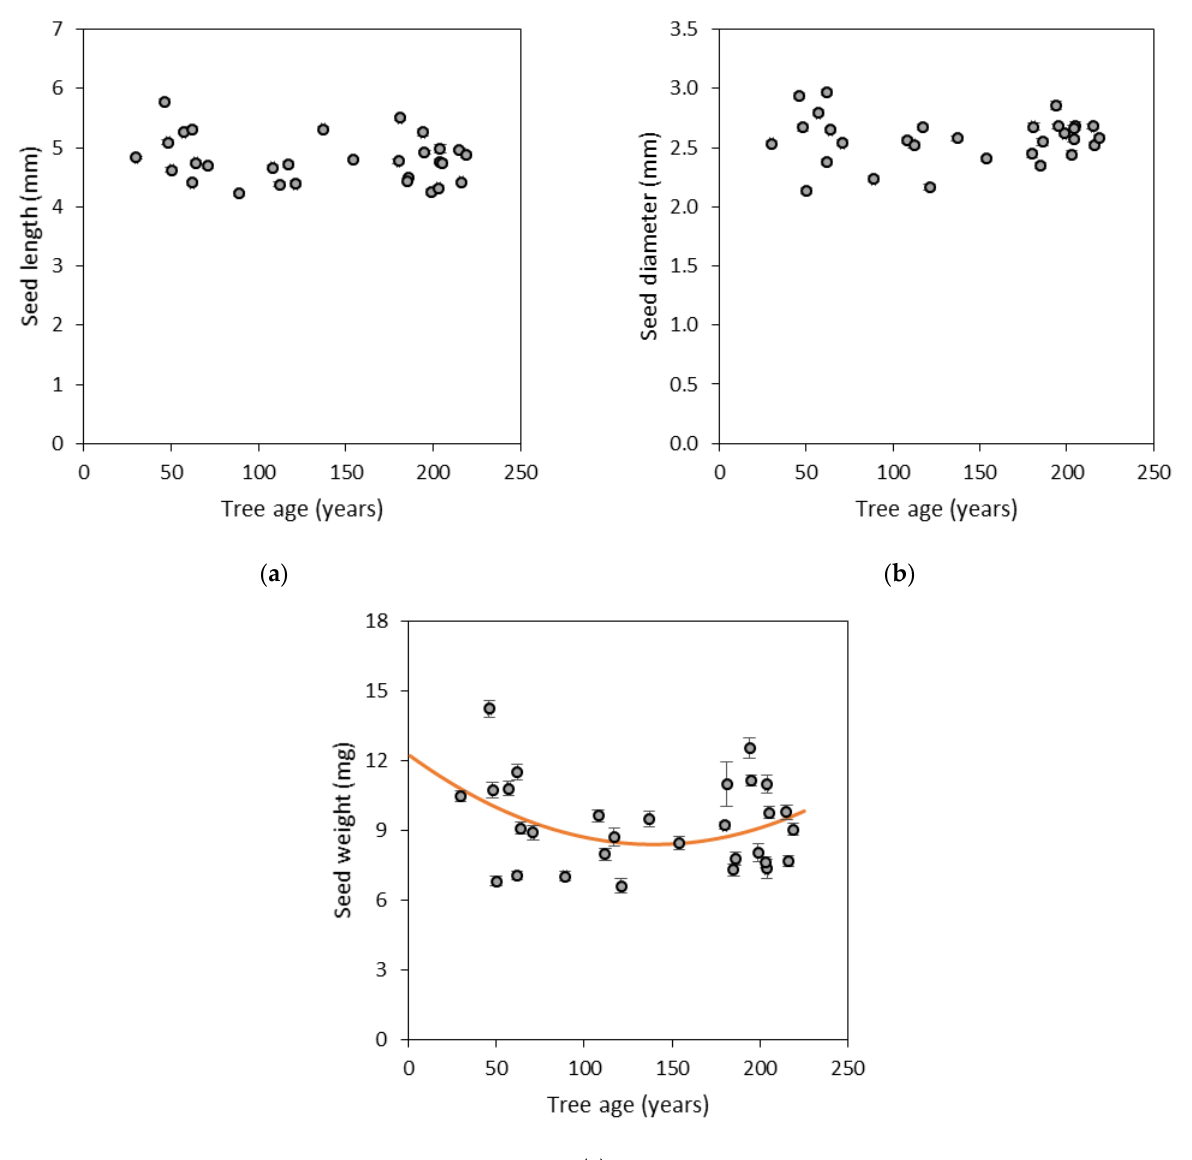
Figure 2. Mean values (±SE) (points) and fitted line (red line) for the morphological parameters of seeds along the range of tree age analyzed: ( a ) length (in mm); ( b ) diameter (in mm) and ( c ) weight (in mg). Fitted line is only shown for those traits showing a significant relationship with age.